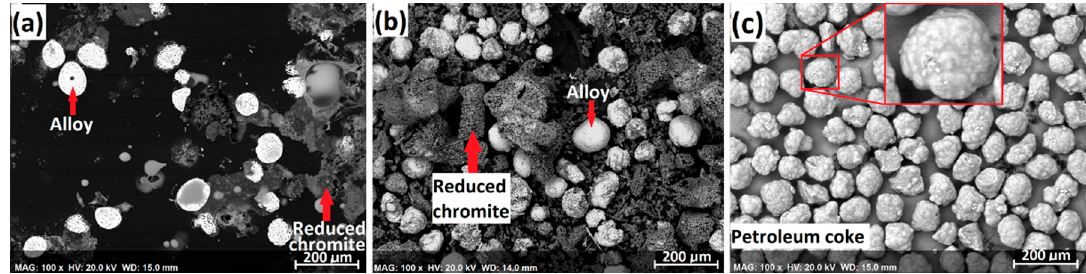
Figure 11. Cross-section ( a ), surface morphology ( b ) of the product from chromite reduction, and ( c ) the petroleum coke used for reduction. the petroleum coke used for